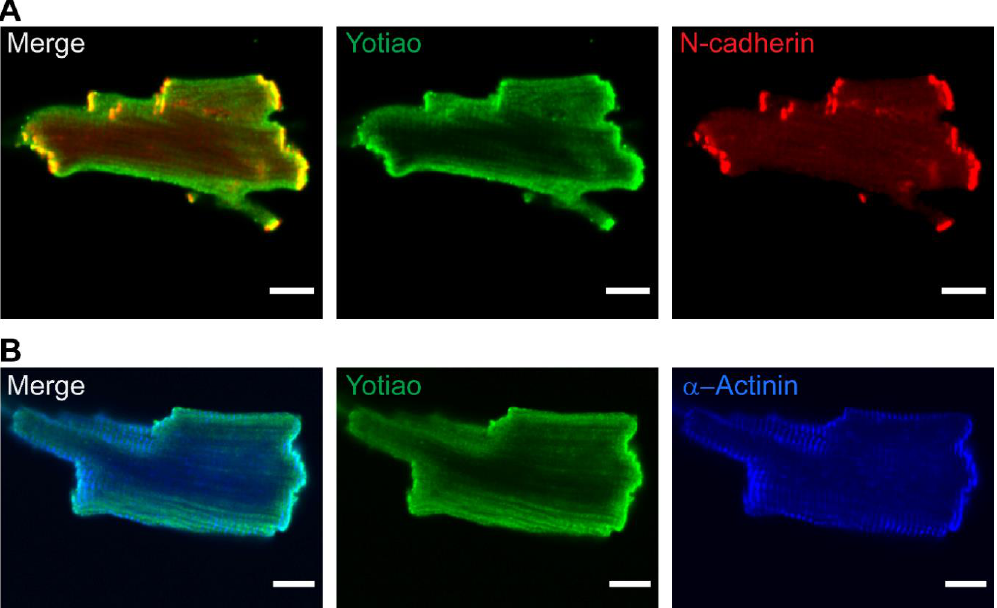
Figure 8. Endogenous Yotiao localizes to sarcolemmal membrane and intercalated discs in adult mouse cardiomyocytes. Wild-type adult mouse CMs were stained with Yotiao (green) and ( A ) N-cadherin (red) or ( B ) α -actinin (blue). Individual channels are shown to the right of composite images. Scale bar represents 10 µm, n > 10 CMs per antibody condition.